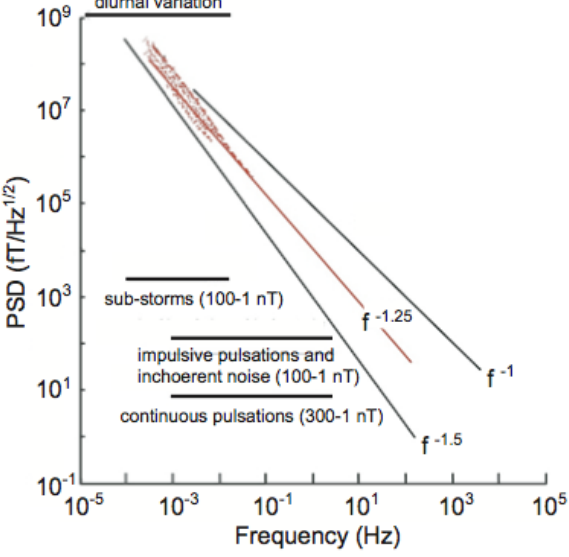
Figure 1. EM natural noise PSD. In the frequency interval from 10 -4 to 10 4 Hz, the noise falls between the two straight lines trending as f -1 and f -1.5 (redrawn after Lanzerotti et al. [1990]).